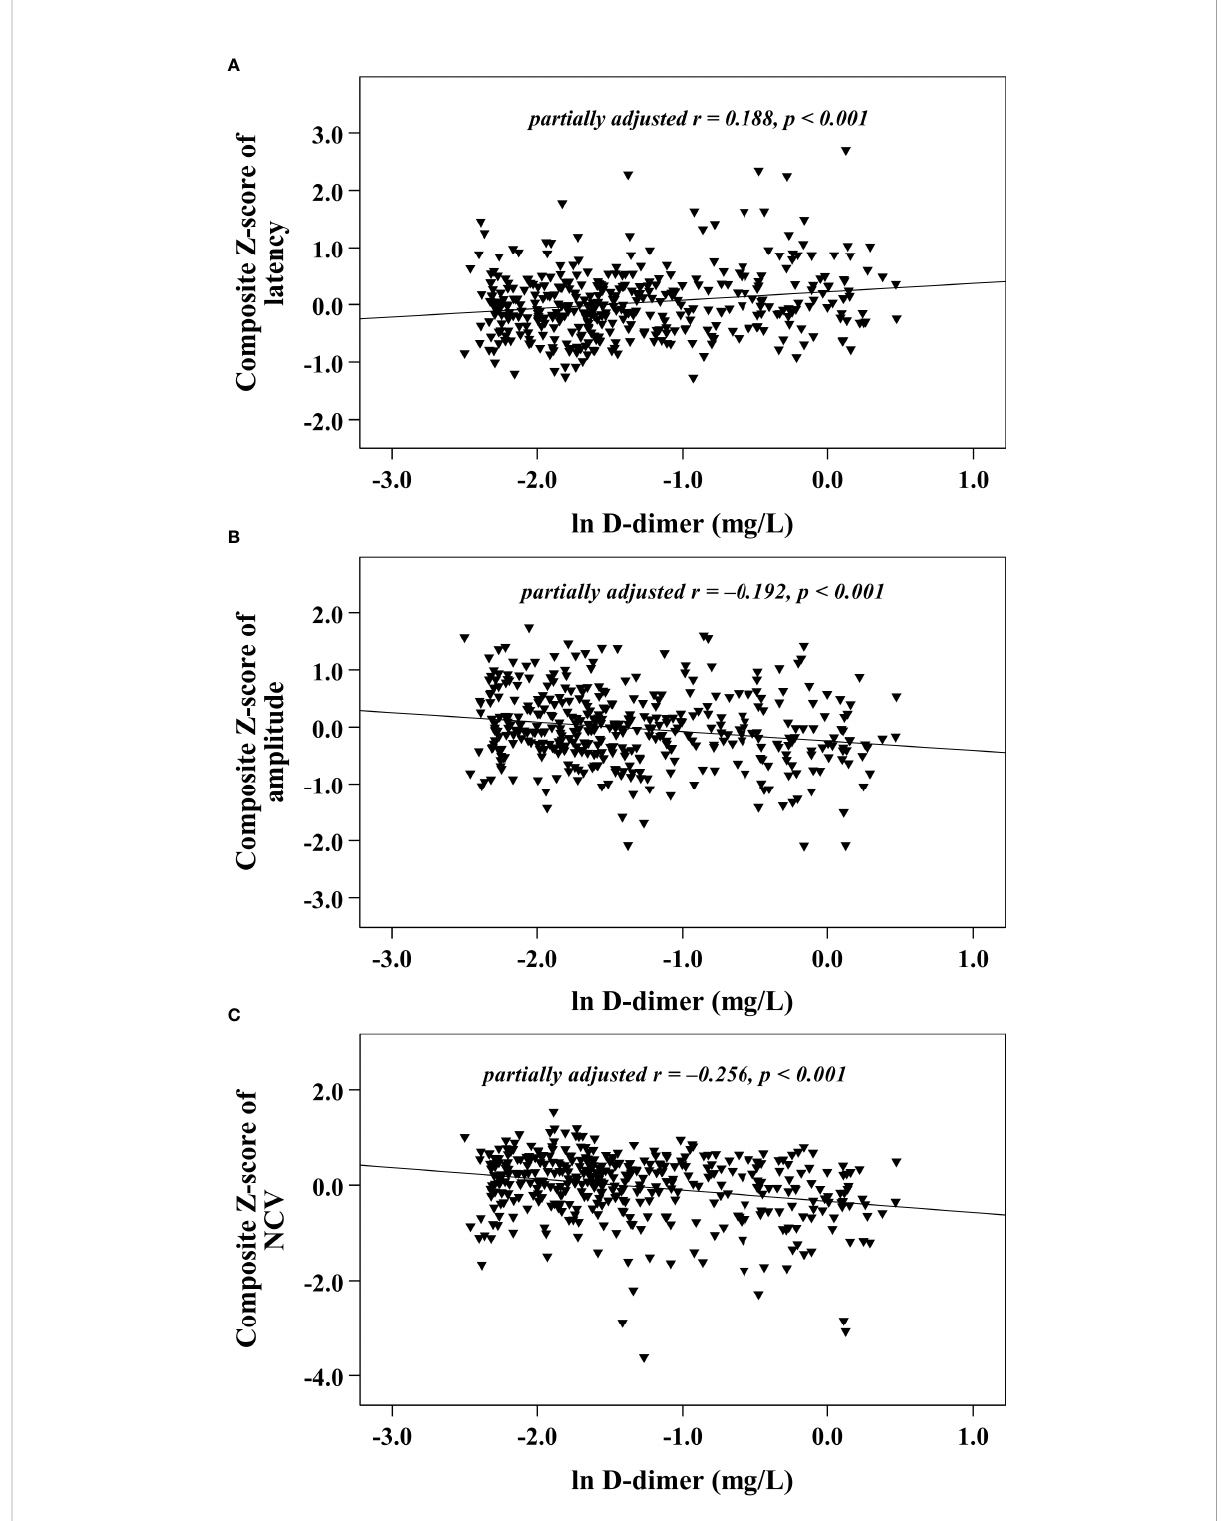
FIGURE 2 Graphically exhibited correlations between D-dimer and nerve conduction indices after adjusting for HbA1c ( A: composite Z score of latency; B: composite Z score of amplitude; C: composite Z score of